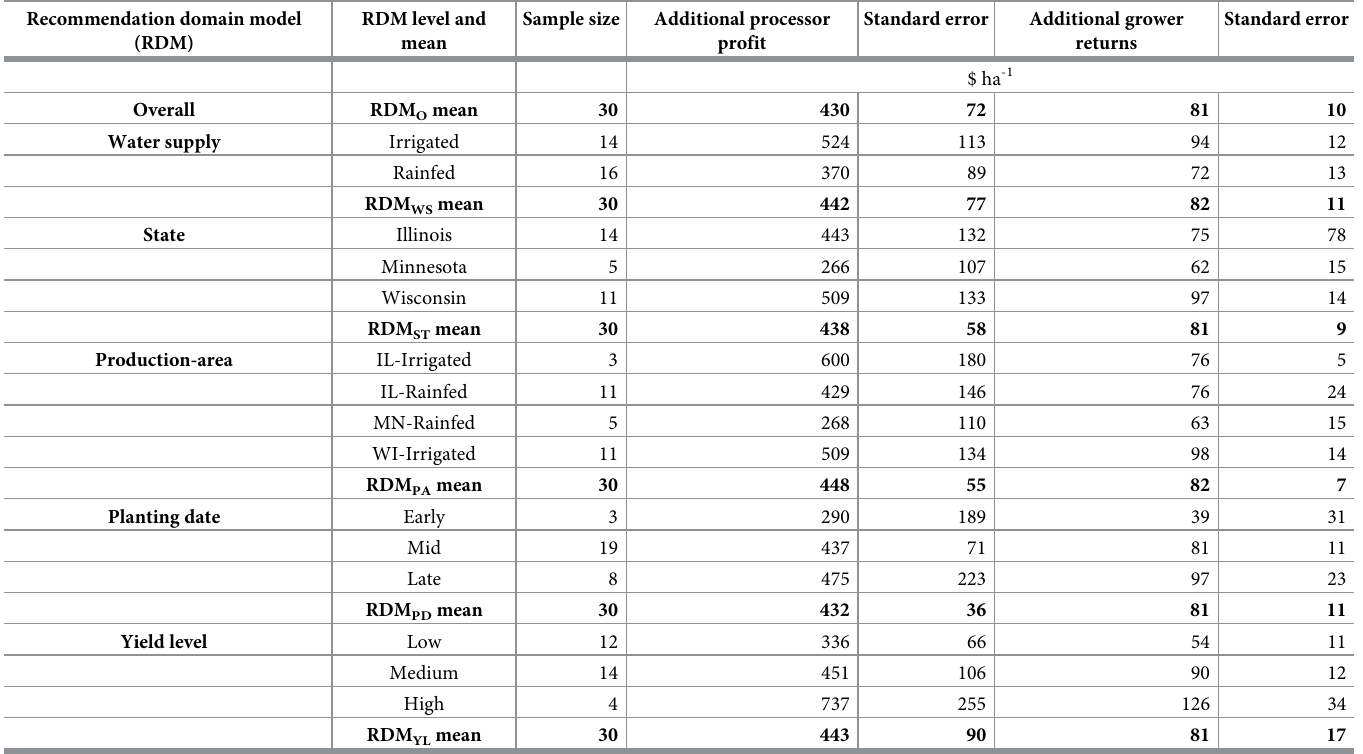
Table 5. Mean additional processor profit ($ha -1 ) and grower returns ($ ha -1 ), standard error, and sample size for each level of the six candidate recommendation domain models (RDM). RDM mean additional processor profit and grower returns were determined using the weighted average of RDM levels. For a description of how additional processor profit were calculated, see Fig